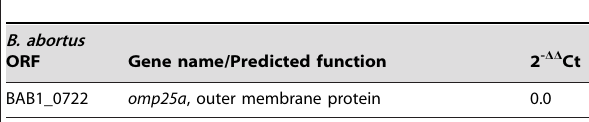
Table 1. Transcriptional level of Brucella genes obtained by quantitative real-time PCR